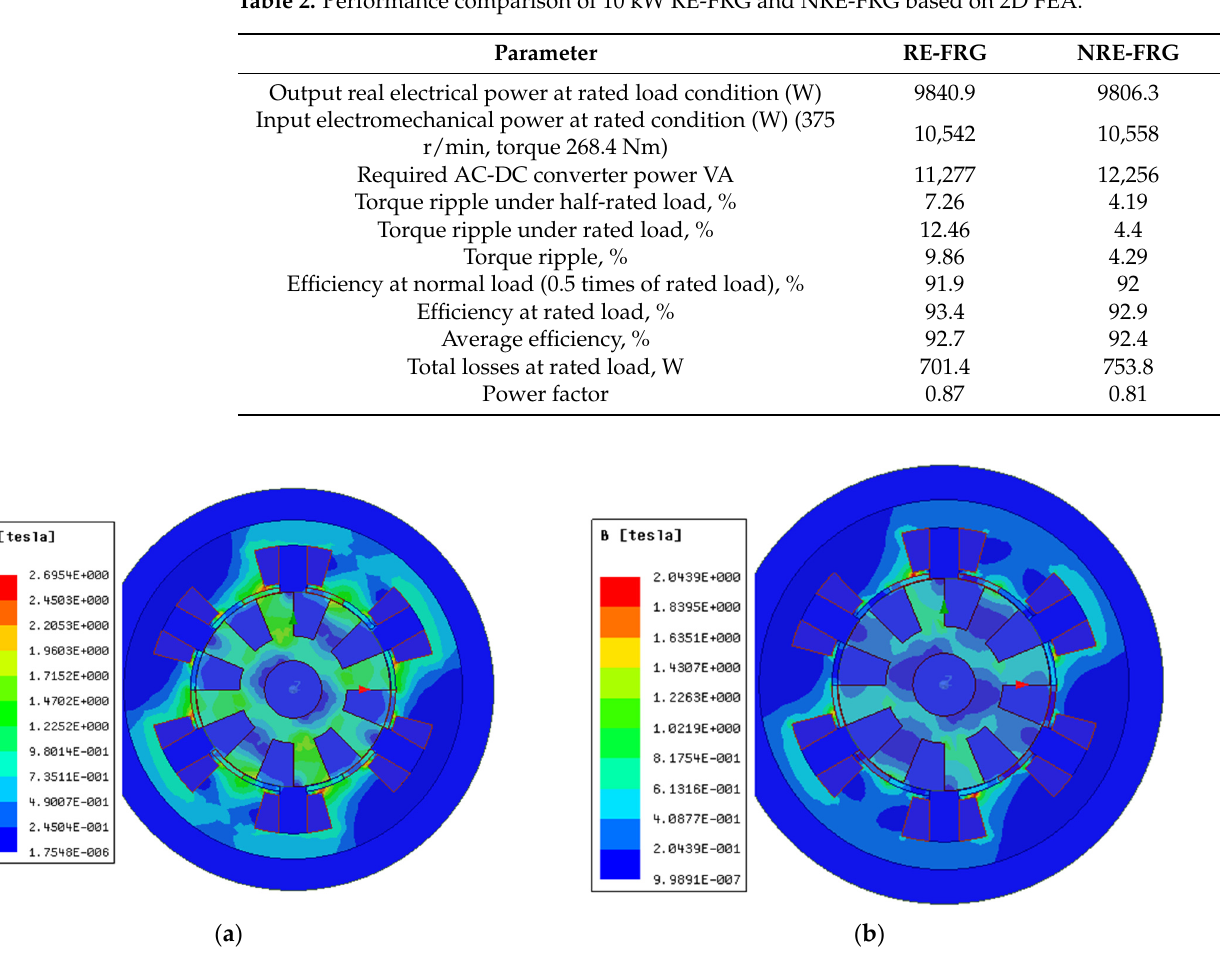
Table 2. Performance comparison of 10 kW RE-FRG and NRE-FRG based on 2D FEA.